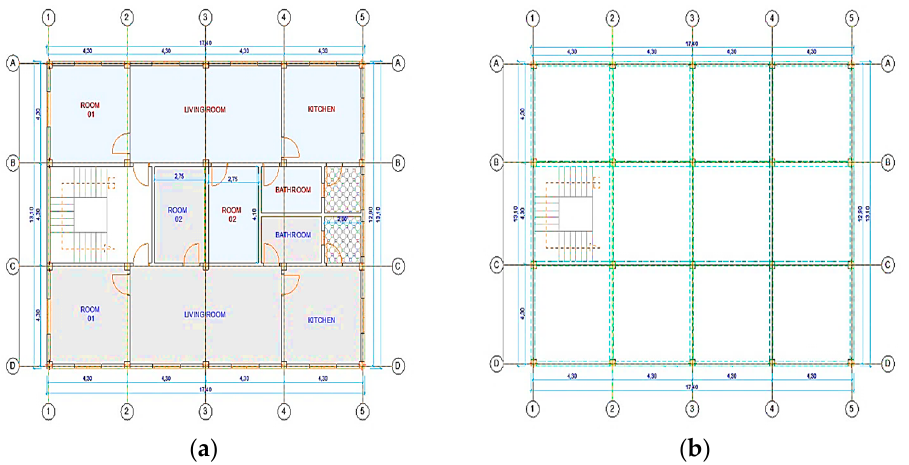
Figure 2. Typical plan view for the considered building: ( a ) architectural plan, ( b ) structural system showing the considered frame (all dimensions in m). Table 1. Mechanical properties of the materials.